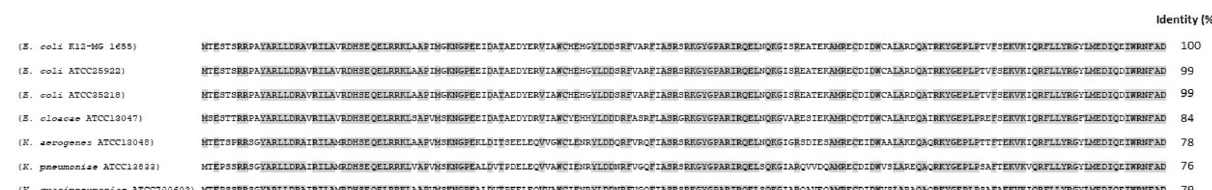
Figure 3. Amino acid sequence alignment of homologous RecX proteins. Conserved amino acidic regions are shaded in grey. Percentage of aminoacidic sequence identity of SIF homologous among Enterobacterales strains using E. coli MG1655 as reference strain was also